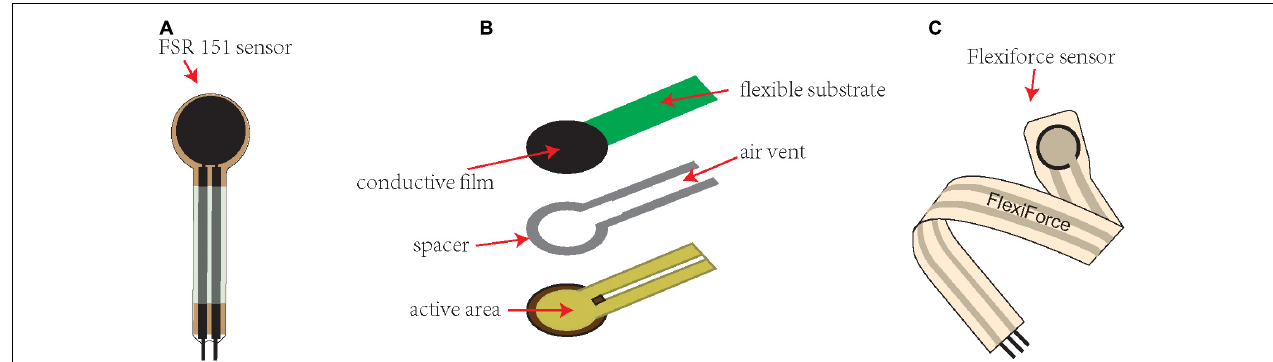
FIGURE 1 | Commonly used piezoresistive sensors for bite force measurement. (A) An illustrative figure of the FSR 151 (Interlink Electronics Inc., Camarillo, CA, United States) sensor. (B) An illustrative figure showing the construction of the FSR151 sensor, consisting of two thermoplastic plastic sheets. Two conductive electrodes crossing each other are embedded on the bottom sheet, and semiconductive polyetherimide ink is coated on the top sheet. (C) An illustrative figure of the Flexiforce (Tekscan, South Boston, MA, United States) sensor.